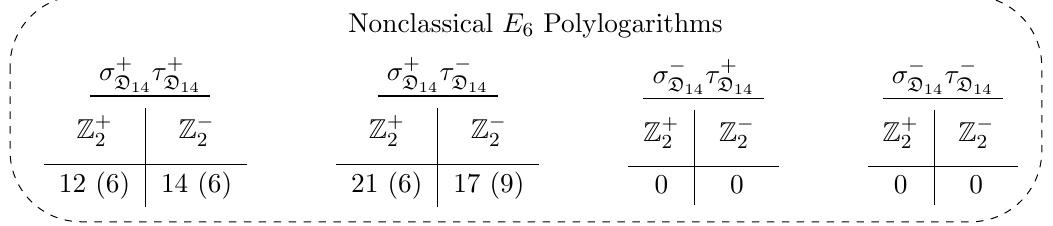
cluster algebra, 6